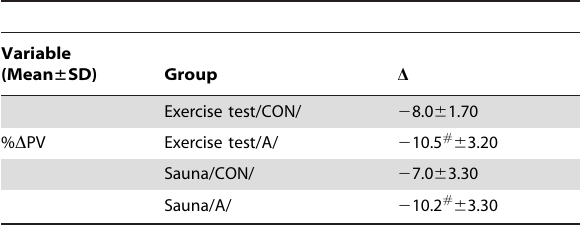
Table 3. Changes in plasma volume (% D PV) in the groups CON and A after exercise test and after sauna bathing.